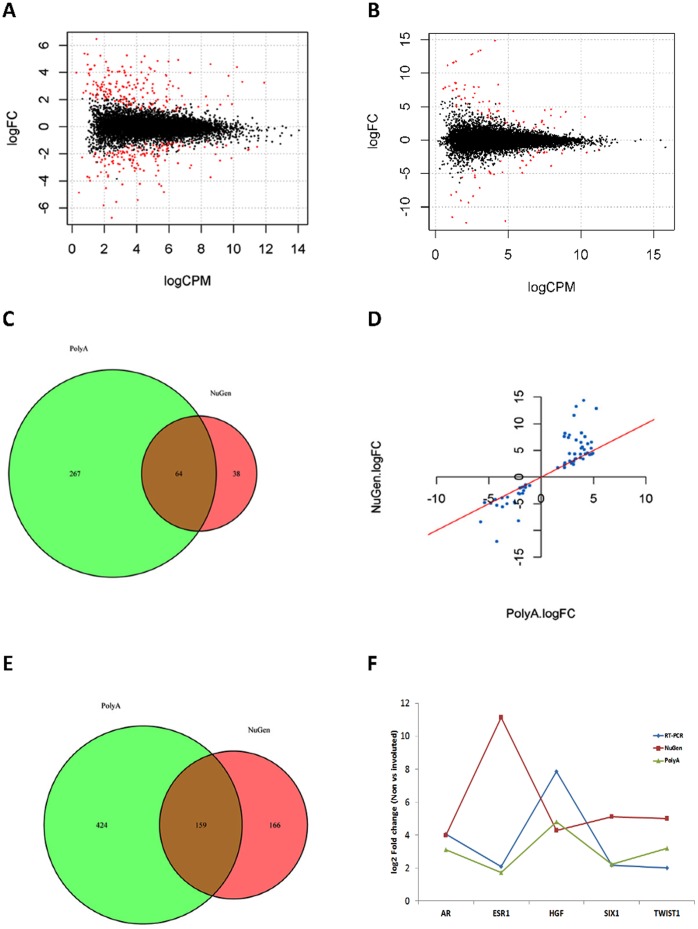
Differentially expressed genes in biologic replicates.A: Differentially expressed genes at FDR 0.05 (highlighted in red) between non-involuted and involuted epithelial phenotypes of the PolyA samples by edgeR. X-axis is the average expression across groups (normalized at count per million) in log2 scale. The Y-axis is the log2 fold change between non-involuted and involuted samples. B: Differentially expressed genes at FDR 0.05 (highlighted in red) between non-involuted and involuted epithelial phenotypes of the NuGEN samples by edgeR. X-axis is the average expression across groups (normalized at count per million) in log2 scale. The Y-axis is the log2 fold change between non-involuted and involuted samples. C: Venn diagram for common and unique DEGs (differentially expressed genes) by the PolyA and the NuGEN preparations at FDR 0.05. D: The scatter plot of log2 fold changes for the 64 common genes in 3C. All genes are in the same direction and most genes agree very well in fold change estimate except some genes have higher fold changes in the NuGEN samples. E: Venn diagram for common and unique DEGs (differentially expressed genes) by the PolyA and the NuGEN preparations at raw p value <0.01. More genes are significant and overlapping but the common genes are in the similar proportion as with FDR cut-off (21% vs 17% of total DEGs by either). F: Comparison of 5 genes between RT-PCR, DEGs by the PolyA preparation, and DEGs by the NuGEN preparations. All genes are differentially expressed by three methods using un-adjusted p value. The fold change estimates agree better between the PolyA preparation and the RT-PCR than between the NuGEN preparation and RT-PCR.